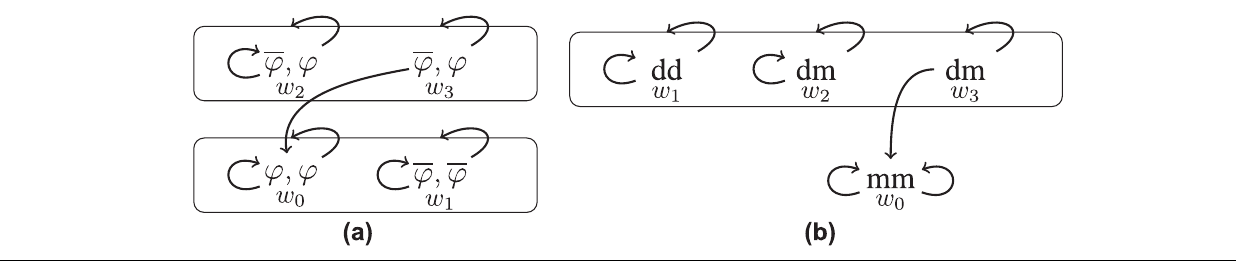
TABLE 12 | Graphs with circular belief states at higher